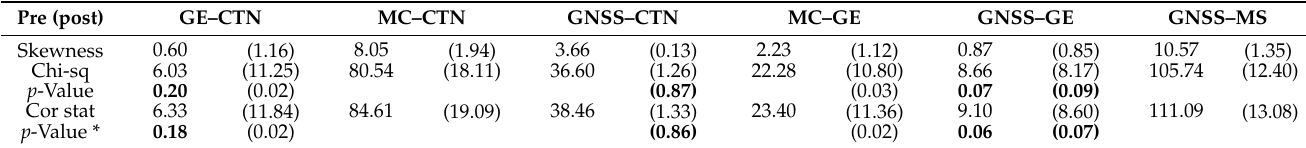
Table 3. Multivariate normality testing (Mardia) for skewness of the pairs ∆ E – ∆ N . The degree of freedom (df) = 4. Values after outliers’ removal are reported between parentheses. * p -Values < 0.02 are omitted. The skewness and chi-square (chi-sq) values are also reported. The resulting bivariate normal distributions are highlighted in bold.